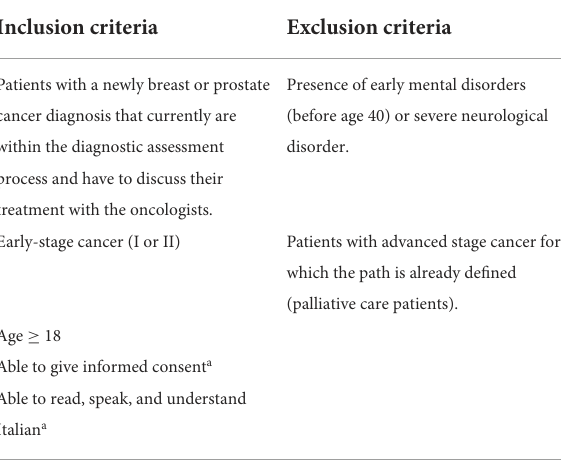
TABLE 2 Inclusion and exclusion criteria for patients. TABLE 3 Inclusion and exclusion criteria for